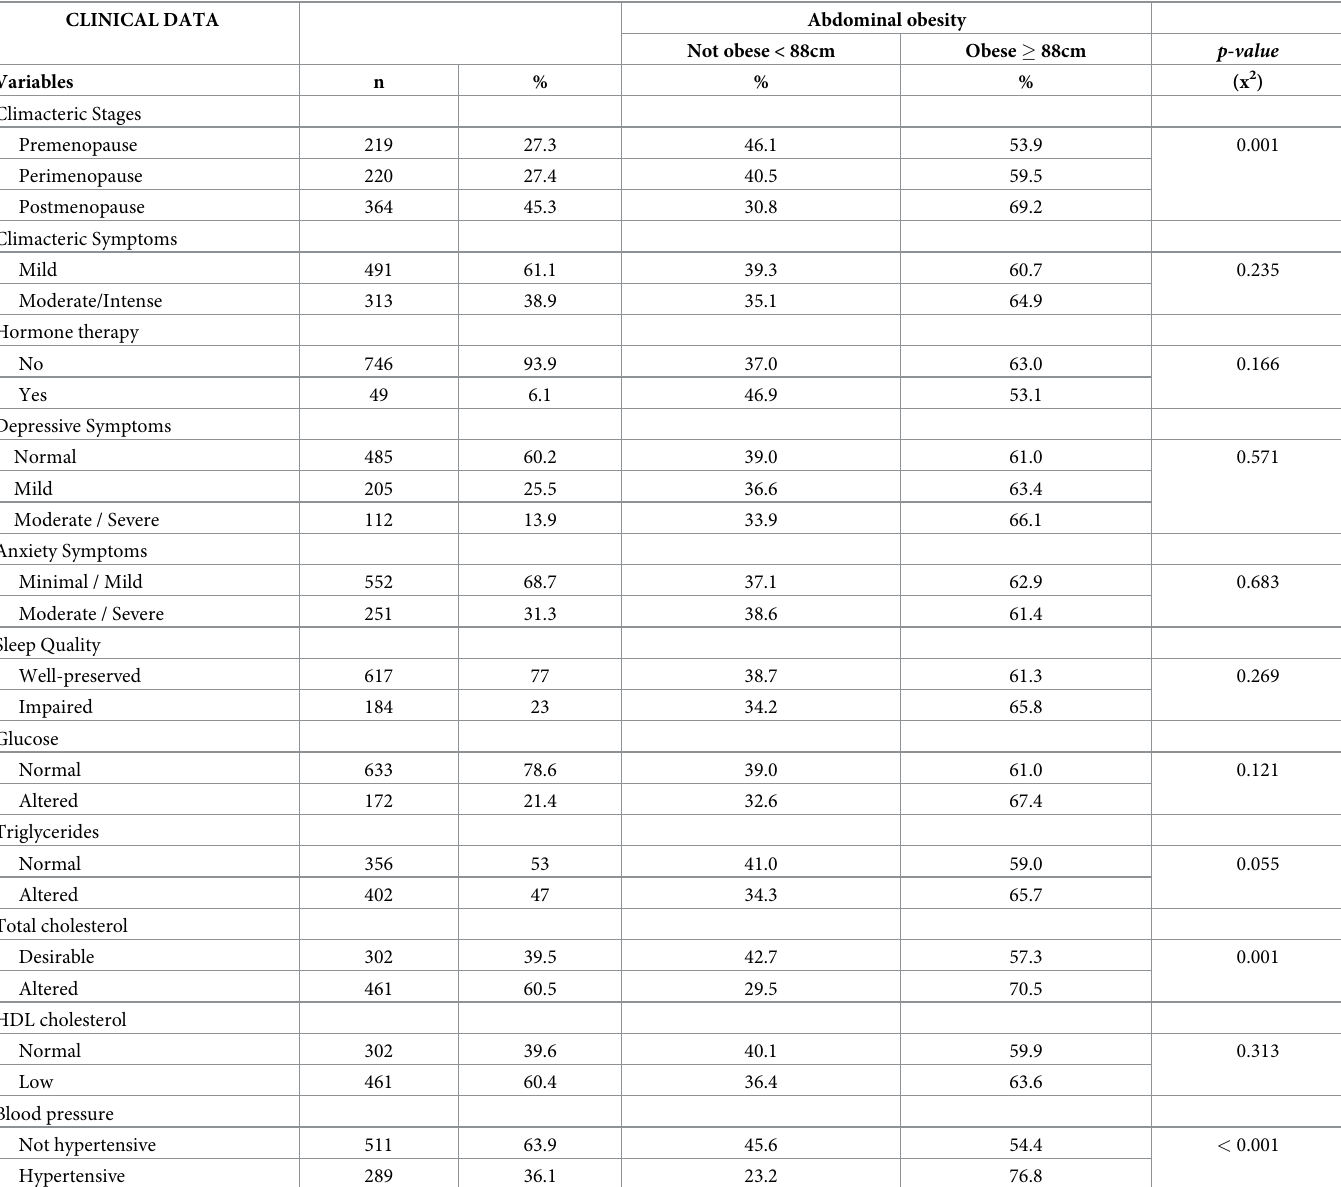
Table 3. Distribution of absolute and relative frequencies and bivariate analysis between abdominal obesity and clinical variables in climacteric women. CLINICAL